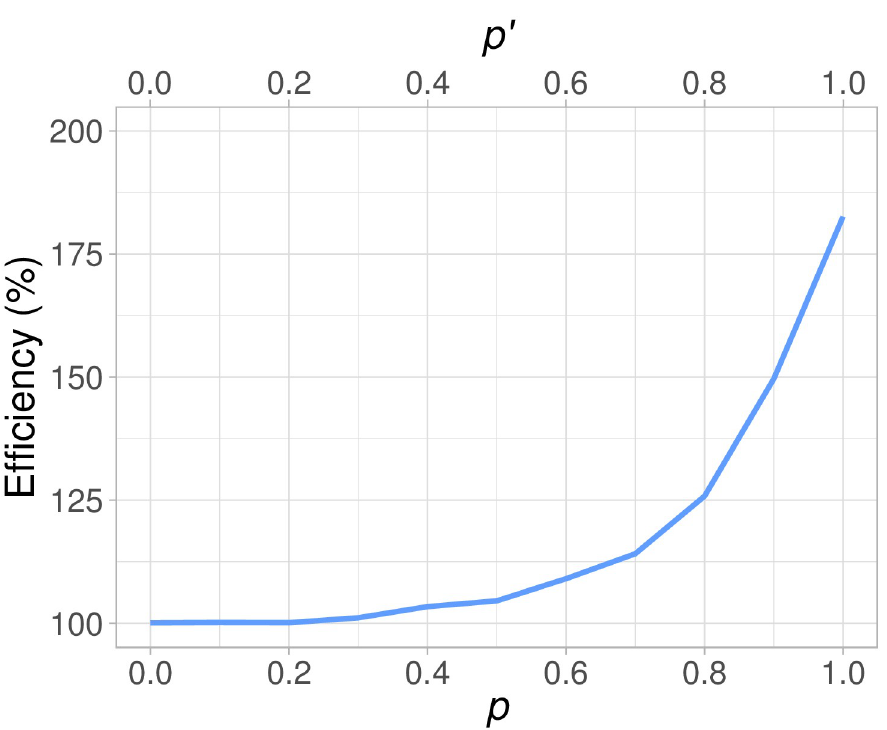
Fig 7. Efficiency of the modified weighted log-rank ( mWLR ) test with respect to the log-rank ( LR ) test assuming matching values of p and p 0 (i.e., ( p = 0, p 0 = 0), ( p = 0.1, p 0 = 0.1), ... , ( p = 1, p 0 = 1)) for a fixed value of m OS months.